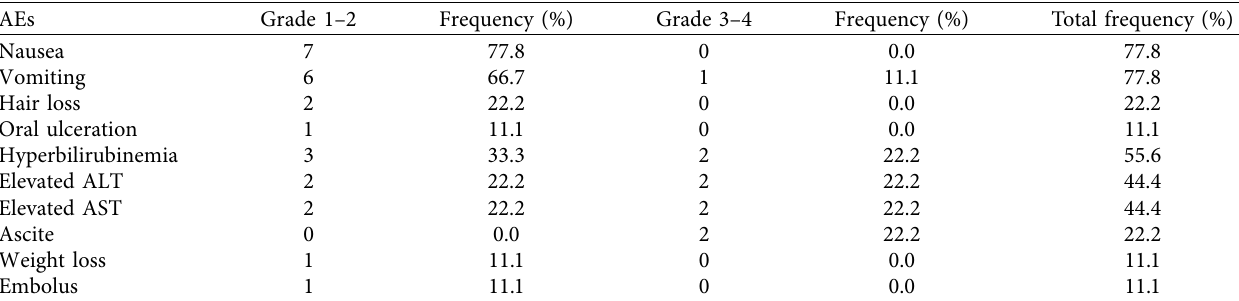
Figure 2: Imagine scans of two PR patients with best response of PR. (a) Tumor size of Patient No.1 at baseline; (b) tumor in the left lobe had shrunk at first imagine assessment; (c) tumor size of Patient No. 3 at baseline; and (d) tumor had partial regression at first imagine assessment. Table 3: Adverse events and